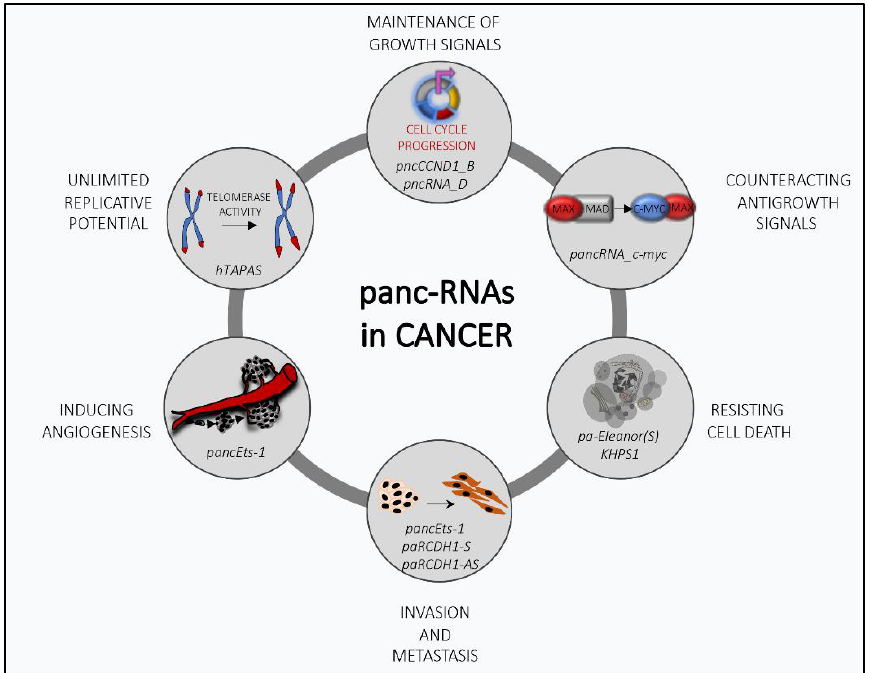
Figure 1. The multifaceted role of promoter-associated noncoding RNAs (pancRNAs) in cancer transformation: PancRNAs can regulate several cancer-related processes by modulating the transcriptional expression of genes involved in tumor progression.